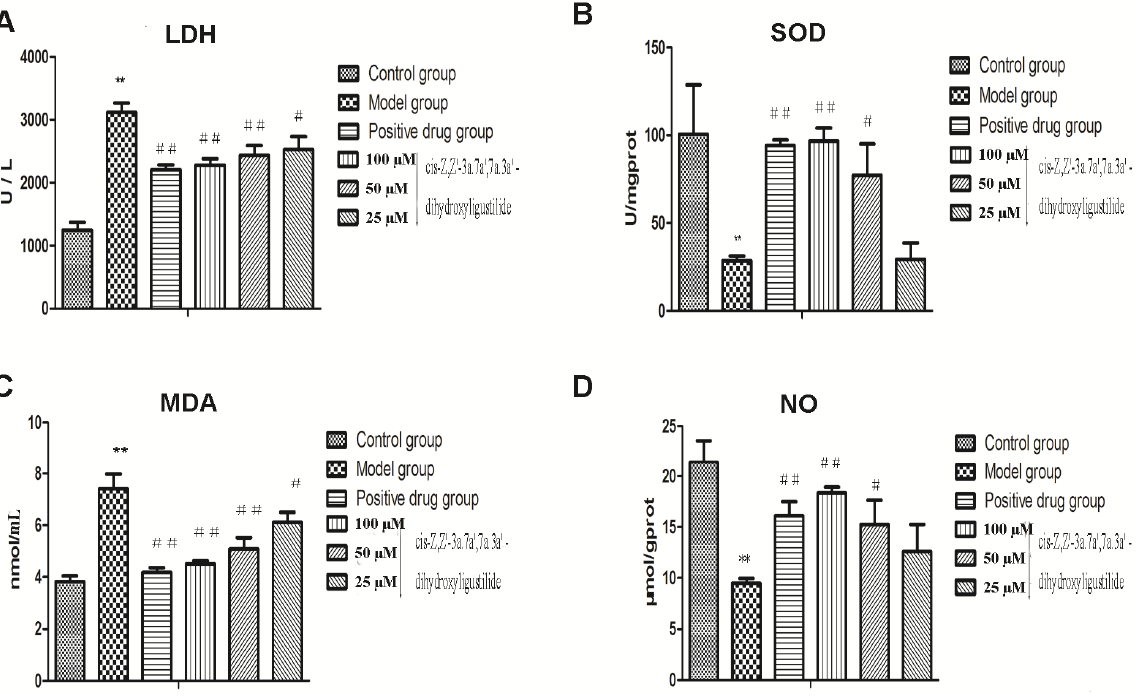
Figure 4. Effects of compound 1 on LDH, SOD, MDA and NO contents in HUVECs injured by H O . Cells were treated with compounds 1 at indicated concentrations for 24 h, and 2 2 Vitamin E (0.001 µM) as a positive drug. The levels of LDH and MDA were decreased, while SOD and NO were increased compared to the model group ( ** p < 0.01 vs. control, ## p < 0.01, # p < 0.05 vs. model).